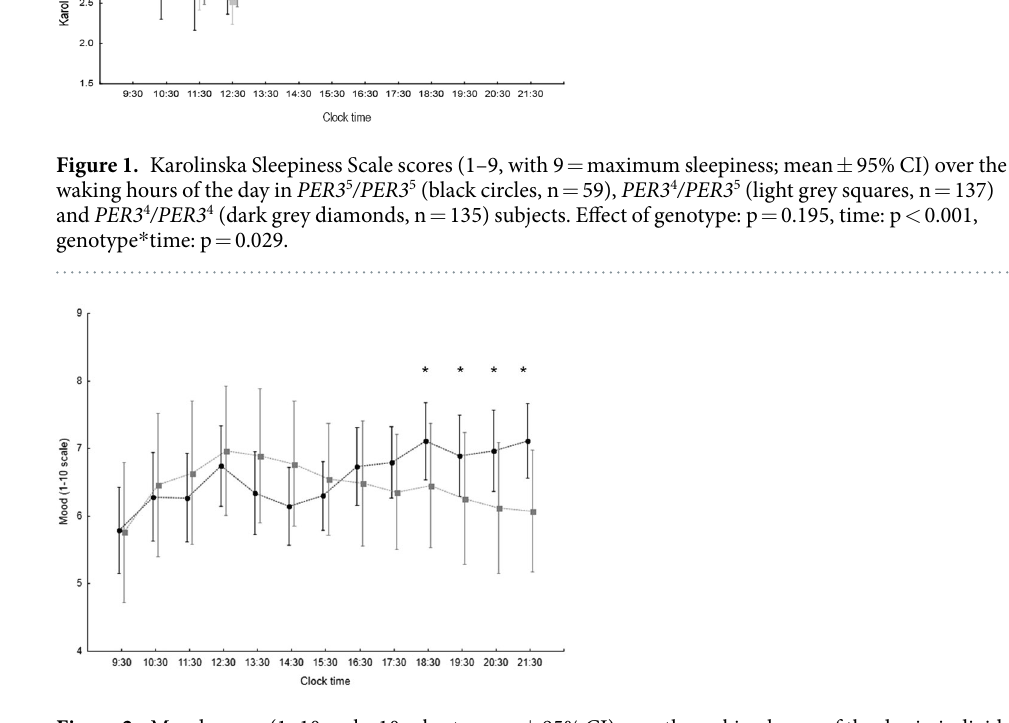
Figure 2. Mood scores (1–10 scale, 10 = best; mean ± 95% CI) over the waking hours of the day in individuals with (grey squares, n = 19) and without (black circles, n = 53) the PER3 G - PER3 4 association. Effect of genotype: p = 0.756, time: p = 0.045, genotype * time: p = 0.020. * Post hoc significant with p < 0.05 at 19:30 h and 20:30 h, p < 0.01 at 18.30 h and 21:30 h.